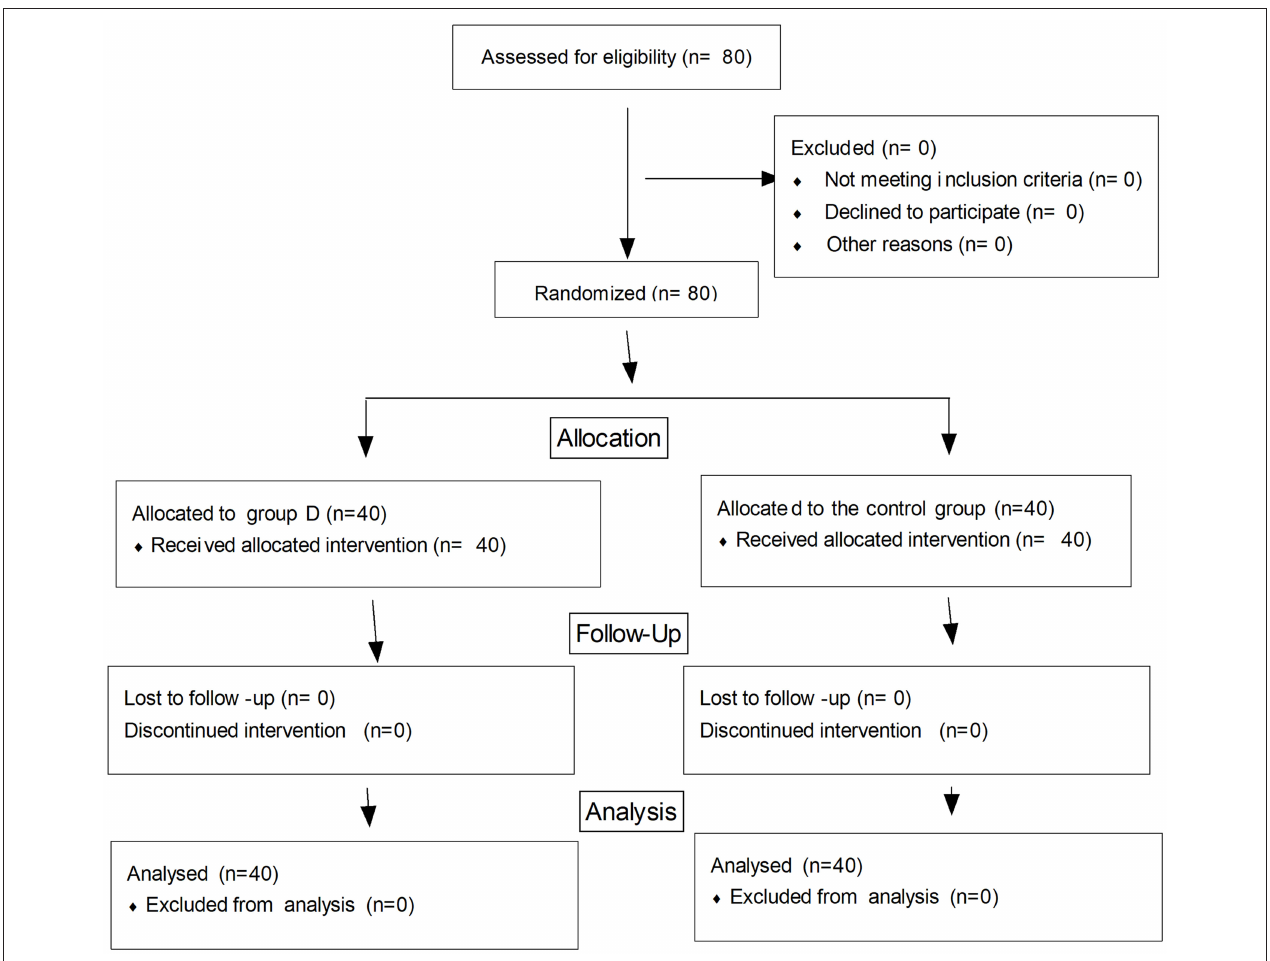
FIGURE 1 | A flow diagram of the study.